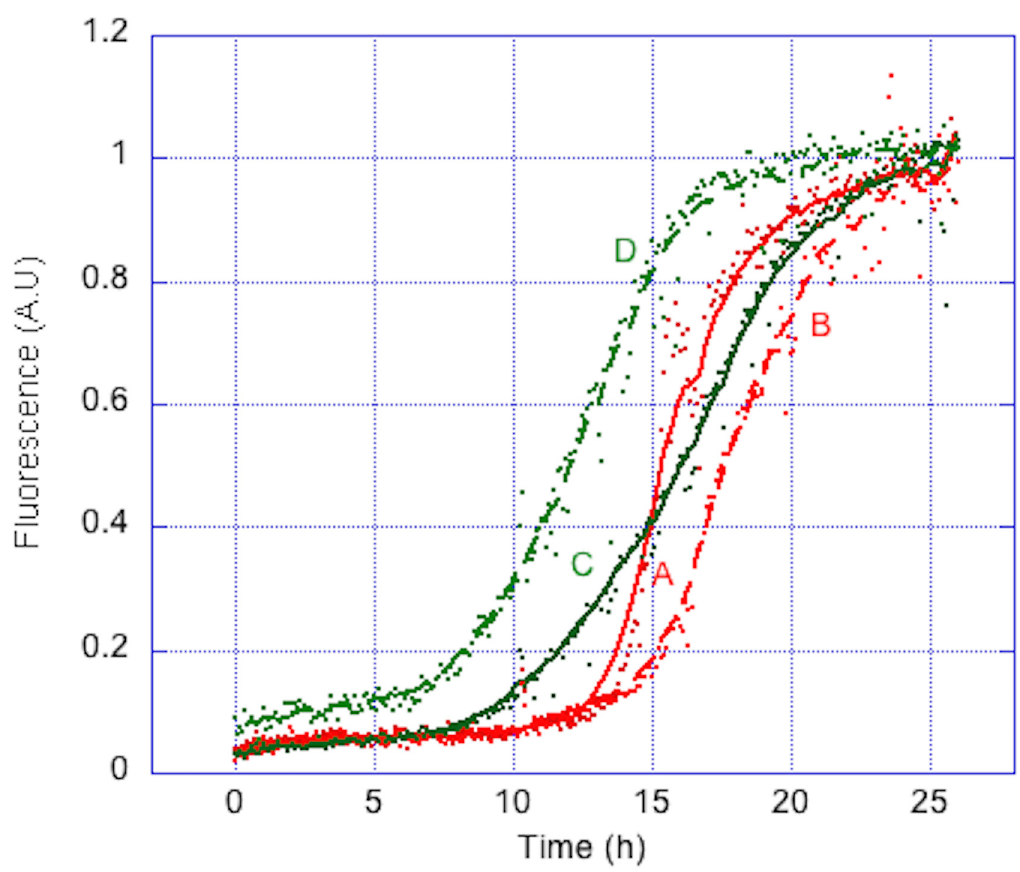
Fig 6. Normalized aggregation curves of MA β 1 – 40 and MA β 1 – 42 . Two different batches of MA β 1 – 40 (A and B) and MA β 1 – 42 (C and D) (20 μ M) aggregate in the presence of Th-T (10 μ M) in phosphate buffer (50 mM, pH 7). Assay was run at 37°C with gentle shaking. Each experiment was run in